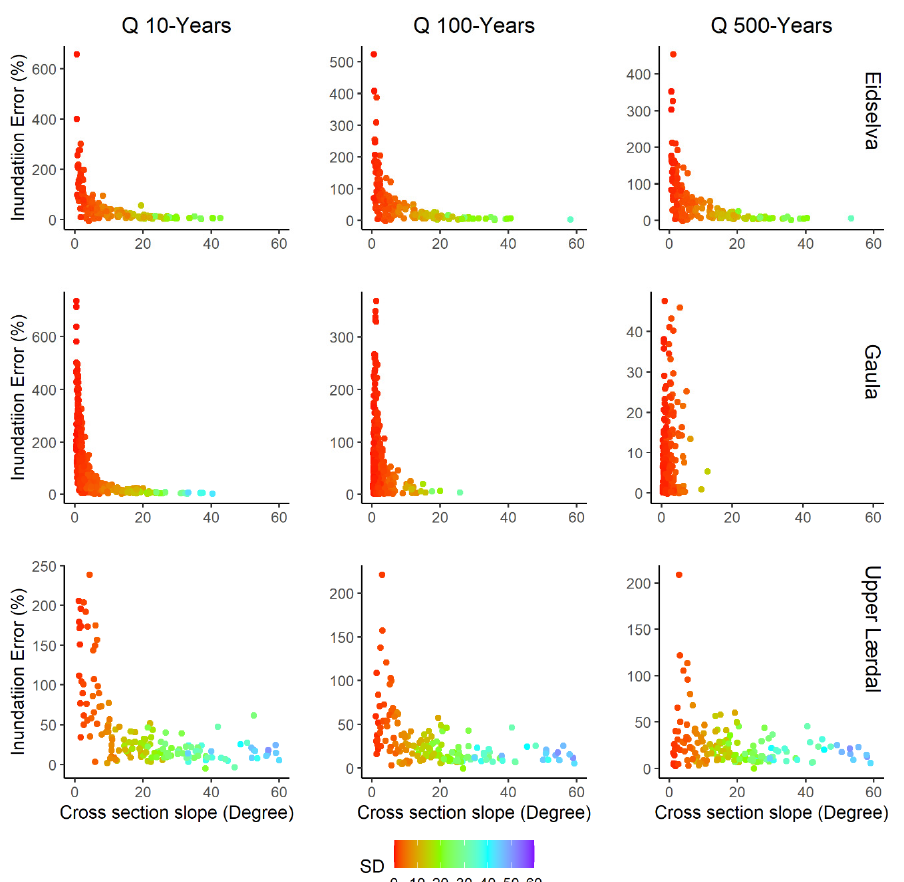
Figure 6. The relationship between the inundation error at the cross-section and the correspondence cross-section slope for Q-10-years, Q-100-years, and Q-500-years for Eidselva, Gaula, and Upper Lærdal. SD is the standard deviation of the bank slope at the cross-section in degrees.